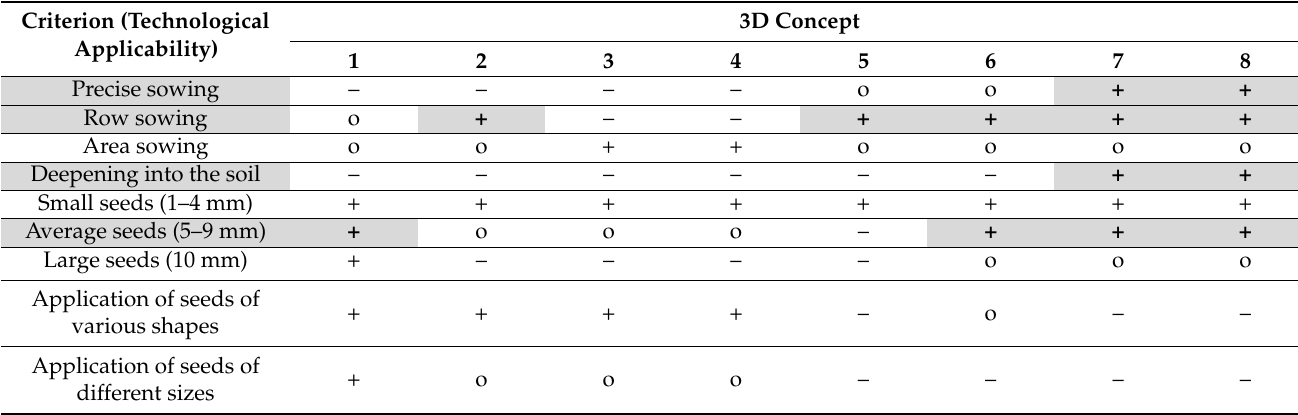
Table 4. Assessment of applicability of sowing devices by technological characteristics.